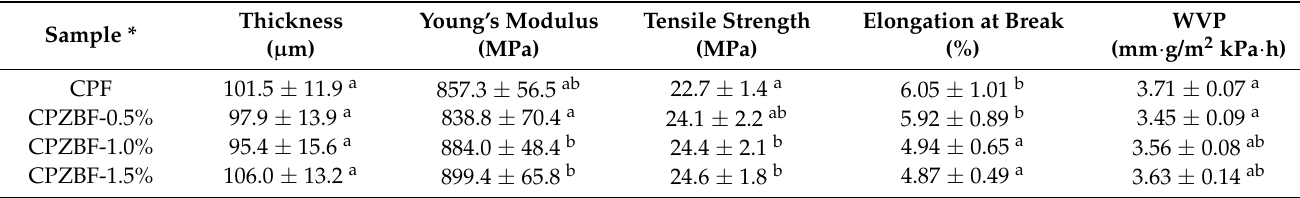
Table 3. Effect of ZnO concentration on the mechanical and water vapor barrier properties of the crosslinked pectin/ZnO bionanocomposite films